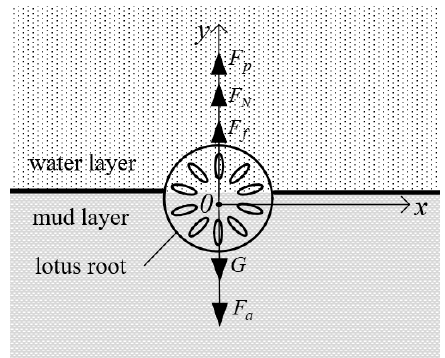
Figure 2. Free-body diagram of the semi-buried lotus root.